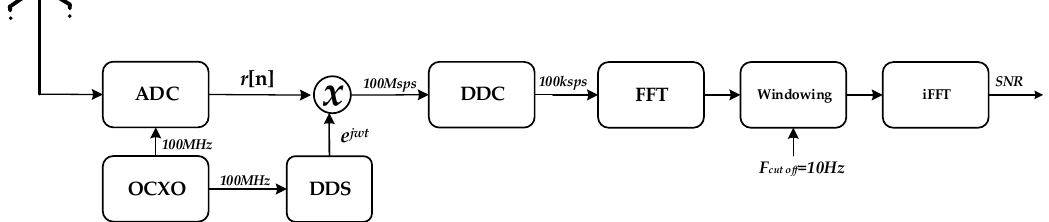
Figure 3. Diagram of the computation process for narrowband sounding. ADC: analog-to-digital converter; DDC: digital-to-digital converter; FFT: fast Fourier transform; SNR: signal-to-noise ratio; OCXO: oven controlled crystal